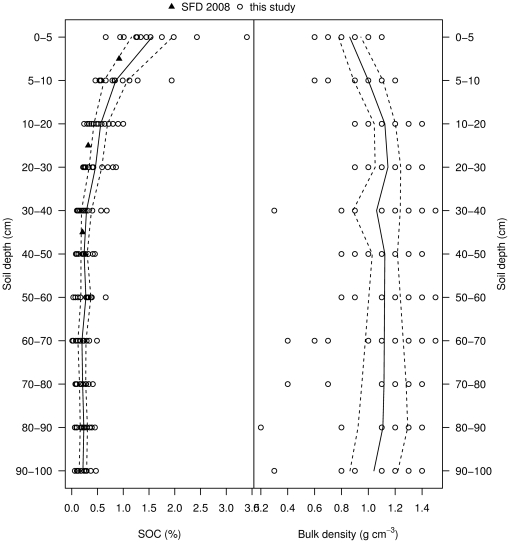
Soil C depth profile.Measured soil organic C (SOC) and bulk density with depth for the Sabah Biodiversity Experiment (Saner 2009). Overlayed points are soil organic C typical of the Kretam soil association (SFD 2008), which is found at Malua Forest Reserve. The line is a smoothed loess curve of mean SOC (±95% CI).